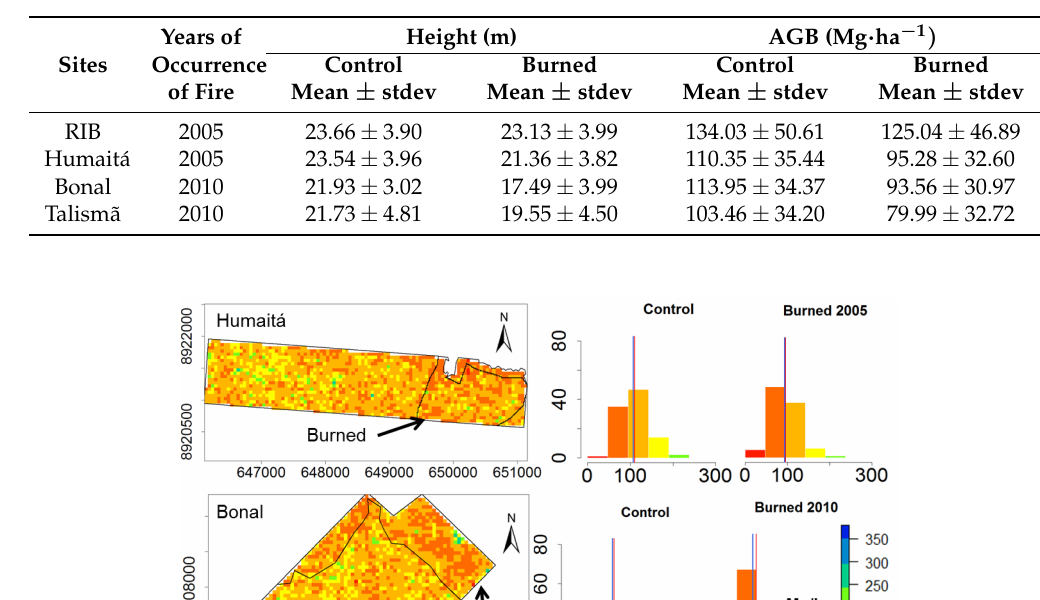
Table 2. Summary statistics from estimated aboveground biomass and Height by LiDAR data for